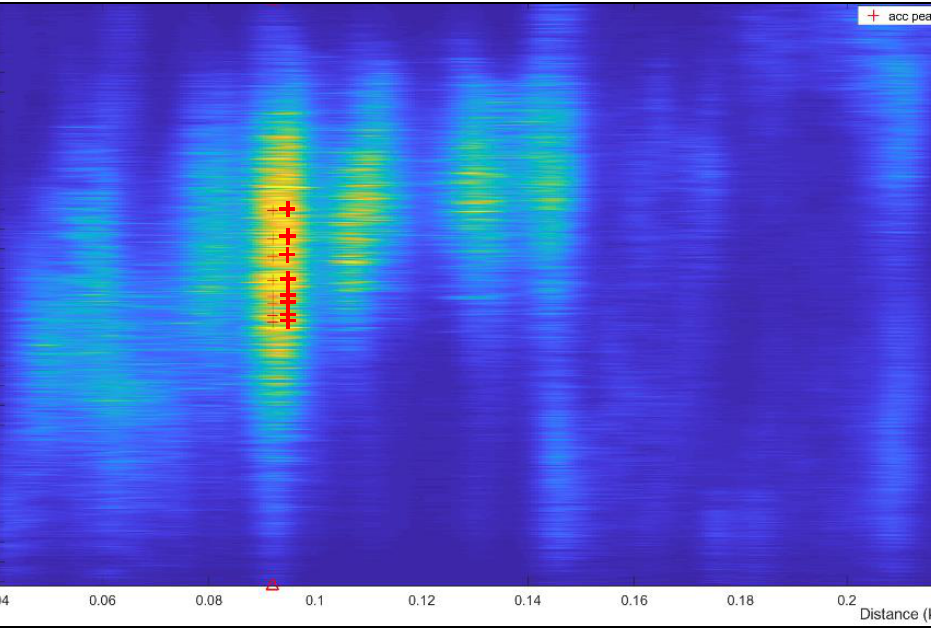
Figure 10. An example of a typical 2-D sinusoidal kernel.